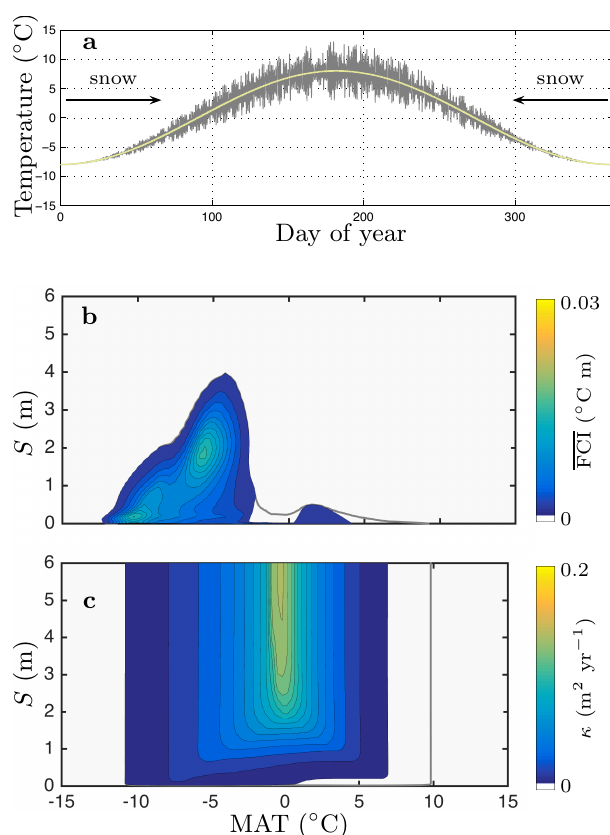
Figure 10. Panel (a) : the amplitude of the diurnal temperature vari- ations at the surface is dampened, simulating an insulating snow cover on the ground during winter (indicated by arrows). Panel (b) : the snow cover limits the integrated frost cracking for MATs around and above 0 ◦ C. The lowest contour level of Fig. 5 is indicated with a black line for easy comparison. Panel (c) : the snow cover reduces the frost-creep efficiency at positive MATs because the sediment is insulated from the cold air temperatures on cold nights in winter. Again, the black line represents the lowest contour level of Fig.